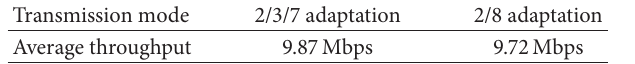
Table 2: Average throughput in the test